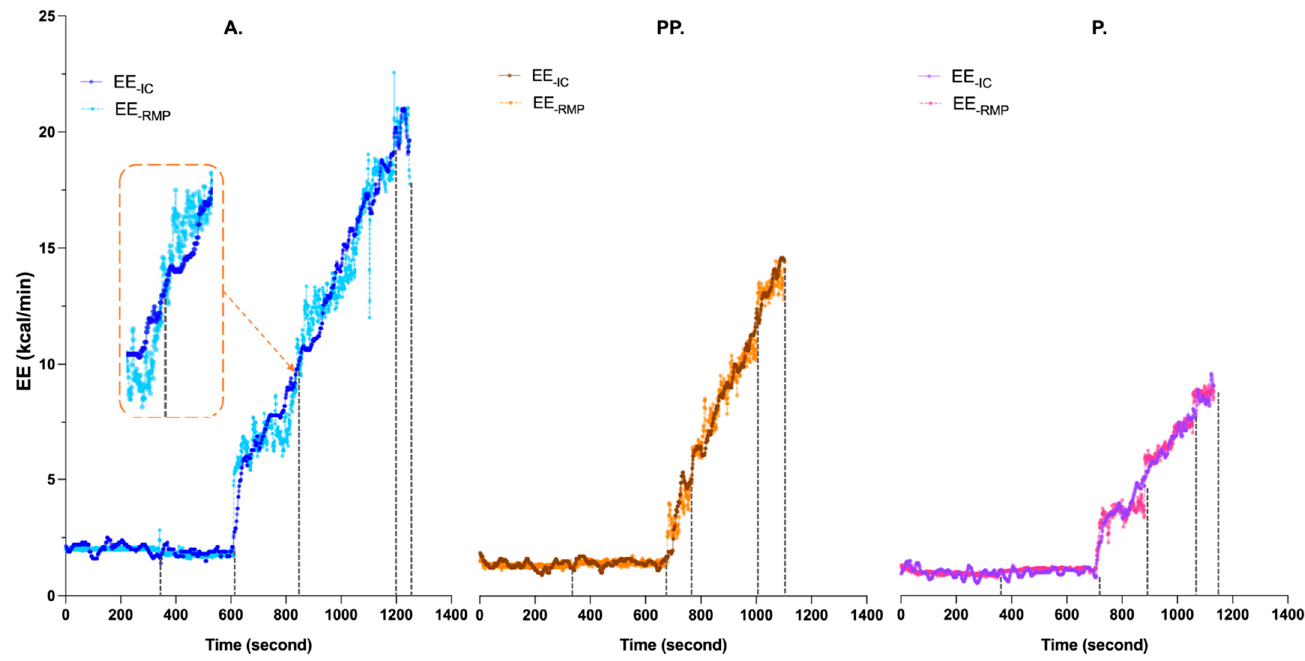
Figure 7. An example of EE -RMP with the TCN model in the three groups. Each dashed line is the dividing line for each intensity level. A: adult; PP: post-pubertal; P: pubertal; EE -IC : energy expendi- ture measured from indirect calorimetry; EE -RMP : energy expenditure estimated from respiratory magnetometer plethysmography.